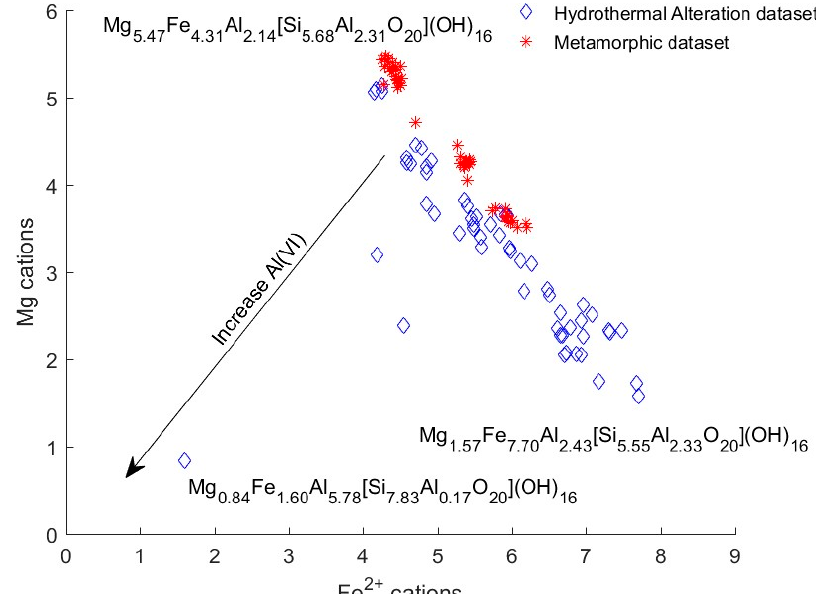
Figure 5. Calculated cation contributions of iron and magnesium in the octahedral sites of chlorite. More octahedral aluminum (Al(VI) in the figure) results in less magnesium, and iron and therefore plots closer to the origin. Chemical formula’s presents the composition of the most Fe- and most Mg-rich chlorite measured, and the outlier containing more octahedral aluminum.